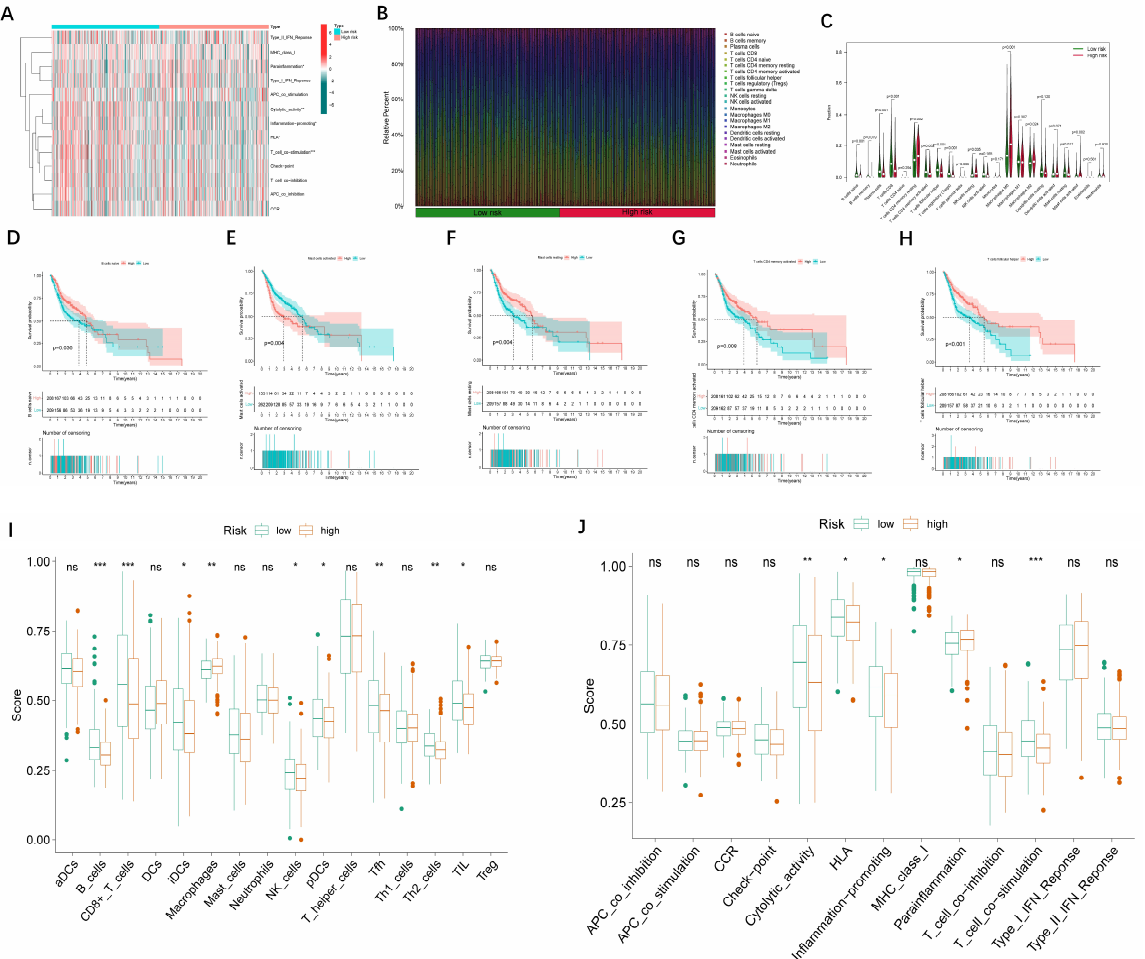
Figure 8. The analysis of immune infiltration in high-risk and low-risk groups. ( A ) A heat map of the differential immune cells in two groups. ( B ) A histogram showing the proportion of immune cells in the two groups. ( C ) A violin plot showing the difference in the level of immune cell infiltration between the two groups. ( D – H ) Kaplan–Meier curves showing the immune infiltrating cells that are associated with prognosis. ( I , J ) A violin diagram showing differences in immune cell and immune function scores between the two groups. * p < 0.05, ** p < 0.01, *** p < 0.001, ns: no signifi- cance.